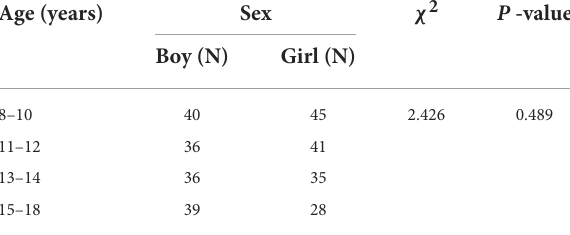
TABLE 1 The sex characteristics of participants in this